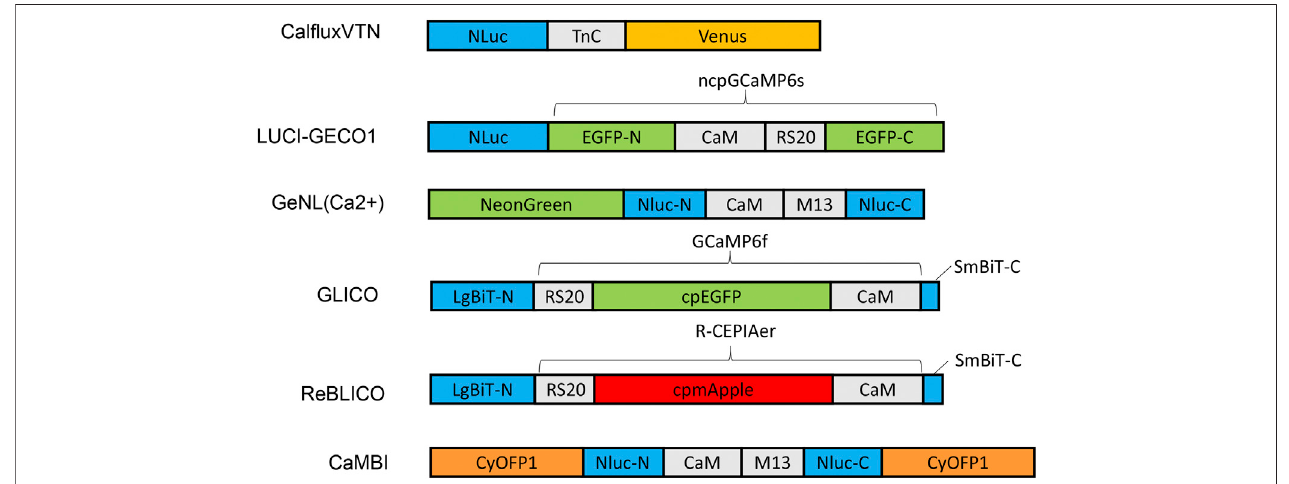
FIGURE 1 | Schematic diagram of various designs and constructs of bioluminescent GECIs based on NLuc or NanoBiT. Abbreviations: LgBiT-N, N-terminal large NanoBiT; SmBiT-C, C-terminal small NanoBiT; CaM, calmodulin; RS20 and M13, calmodulin-binding peptide; NLuc-N and NLuc-C, N-terminal and C-terminal of NanoLuc,